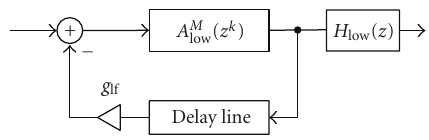
Figure 2: Simplified block diagram showing C lf structure.